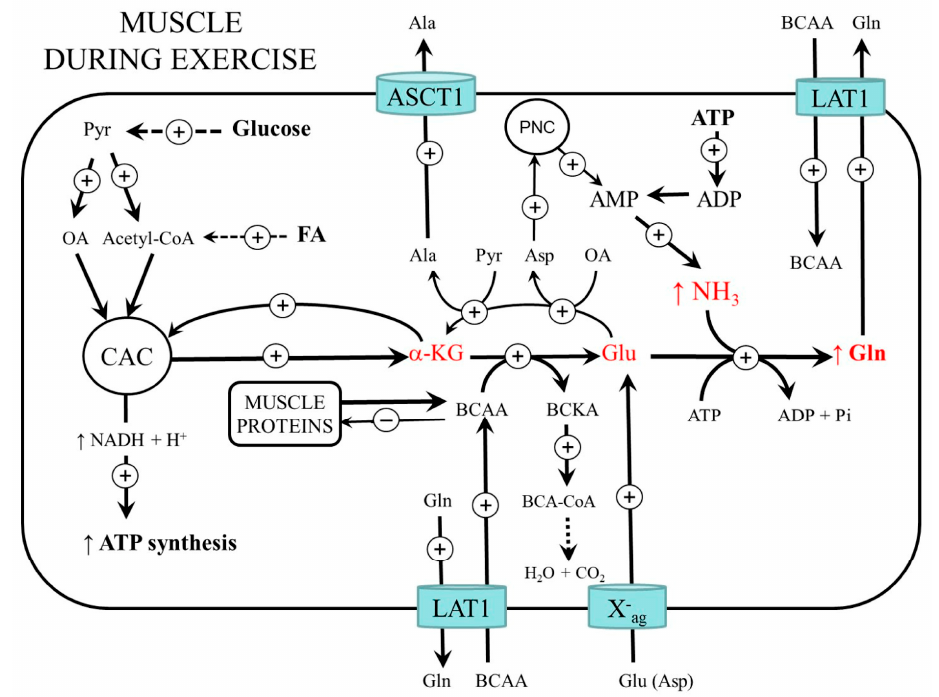
Figure 4. Ammonia and amino acid metabolism in muscles during exercise. Ammonia synthesis increases due to the enhanced turnover of adenine nucleotides. The main pathway of ammonia detoxification in muscles is glutamine synthesis. Increased glycolysis and CAC activity are essential for an adequate supply of α -KG and subsequent glutamate and glutamine synthesis. ASCT1 (alanine, serine, cysteine, and threonine carrier 1); BCAA, branched-chain amino acids; BCA-CoA, branched-chain acyl-CoA; BCKA, branched-chain keto acids; CAC, citric acid cycle; FA, fatty acids; LAT1 (large neutral amino acid transporter 1); OA, oxaloacetate; X -ag (transporter for aspartate and glutamate).